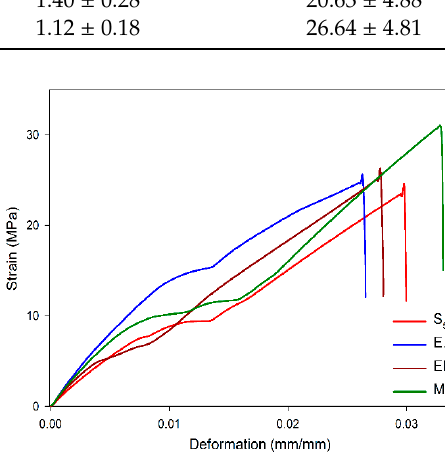
Figure 7. Strain-vs-deformation curves of neat epoxy and epoxy/eggshell compounds. Table 6. Tensile properties of epoxy/eggshell compounds.